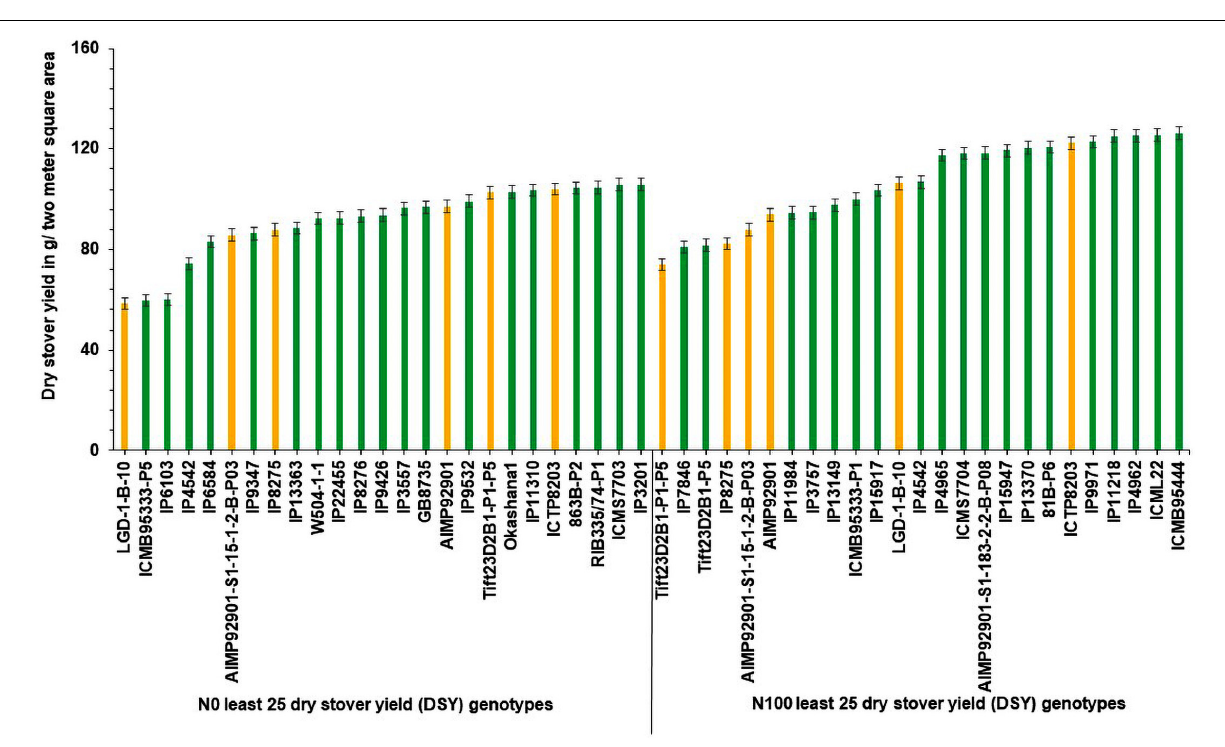
Frontiers in Plant Science |